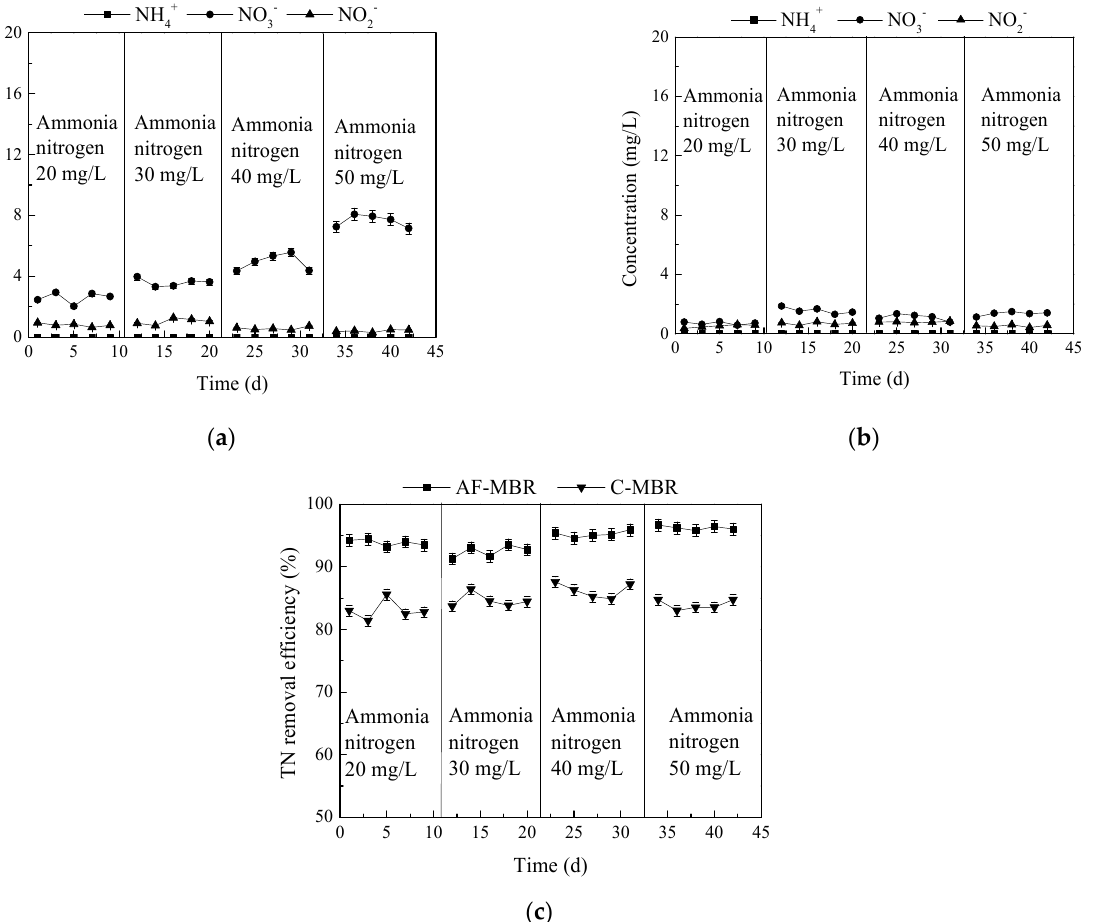
Figure 10. Effect of different ammonia nitrogen loads on nitrogen treatment. ( a ) TN removal efficiency; ( b ) changes of NH 4+ -N, NO 2 − -N, and NO 3 − -N concentrations in AF-MBR; ( c ) changes of NH 4+ -N, NO 2 − -N, and NO 3 − -N concentrations in C-MBR.